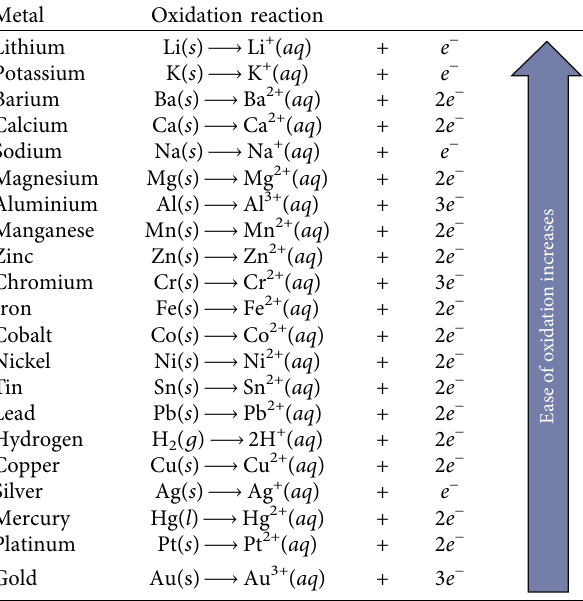
Figure 1: Release of ions and cation migration and exchange reaction in the adsorbed Table 1: Electrochemical series in order of ease of oxidation and displacement [3, 8].